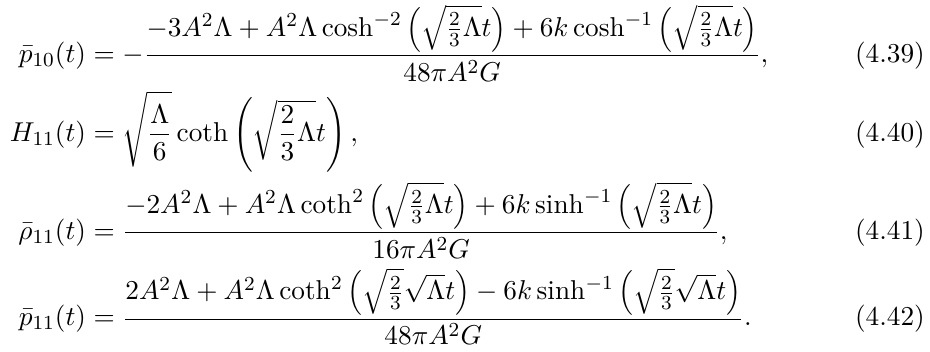
( t ) = A cosh 1 2 10